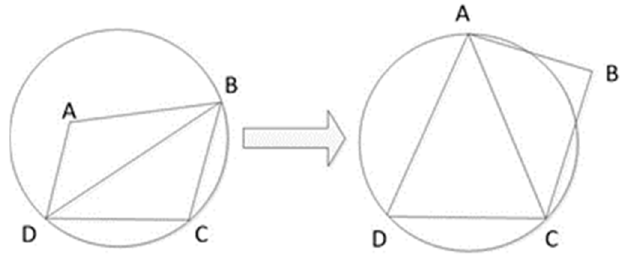
Figure 4. Process of local optimization.